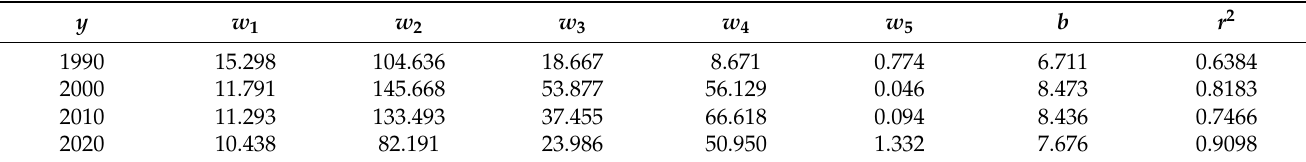
Table 3. Fitting results of the weight and intercept terms for each year.